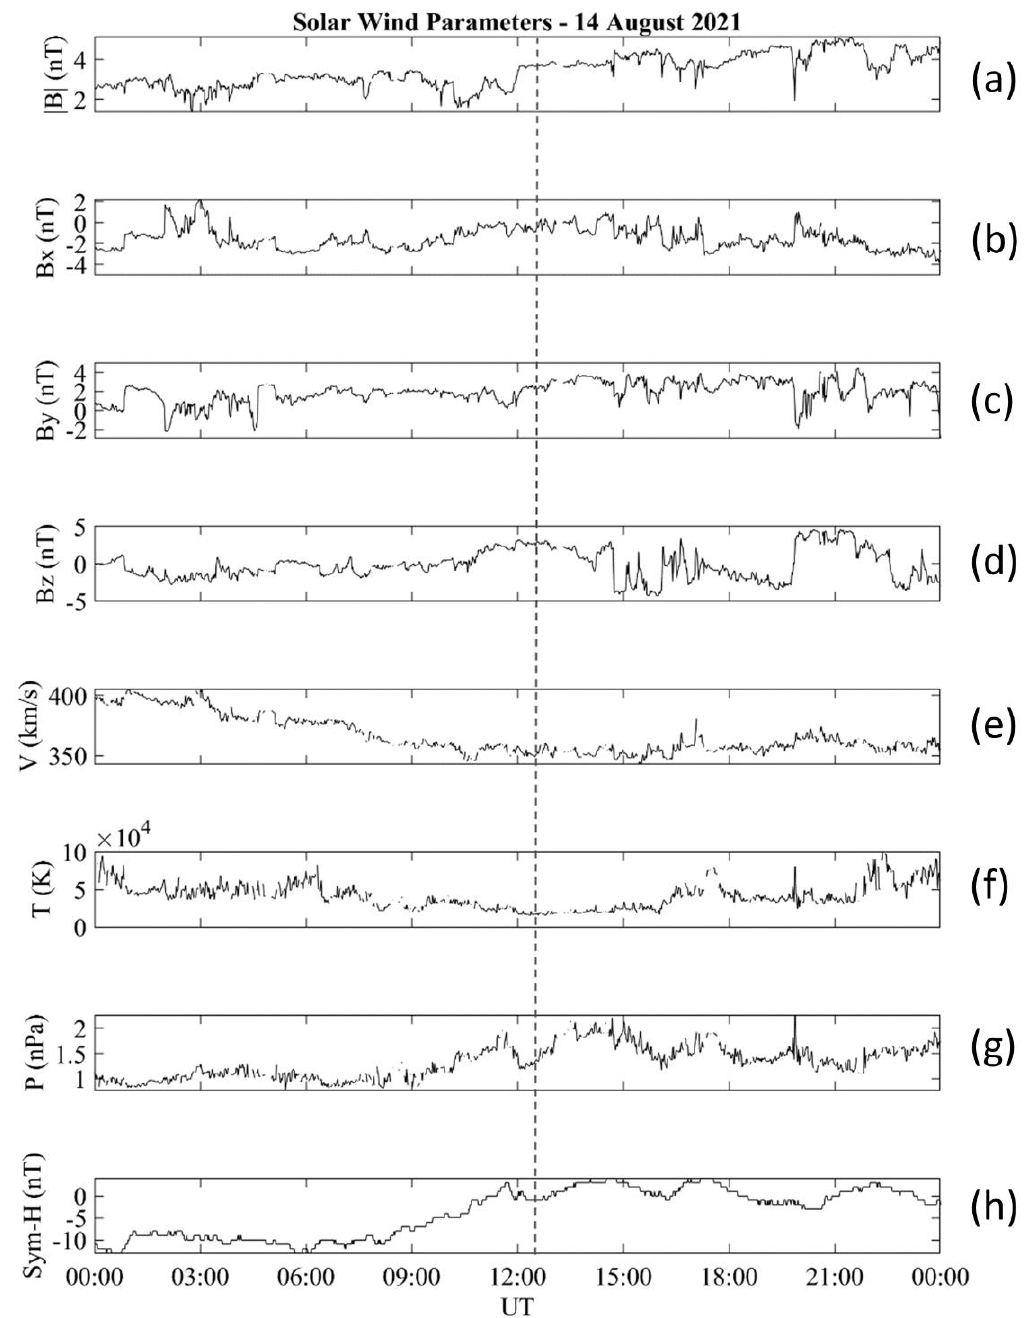
Figure 7. Interplanetary space observations and geomagnetic response at low latitude on 14 August 2021. From top to bottom: Interplanetary Magnetic Field (IMF) intensity ( a ), Bx, IMF component ( b ), By, IMF component ( c ), Bz, IMF component ( d ), solar wind (SW) velocity ( e ), SW temperature ( f ), SW dynamic pressure ( g ), and SYM-H index ( h ) variations. The red dashed line marks the time of the earthquake occurrence.